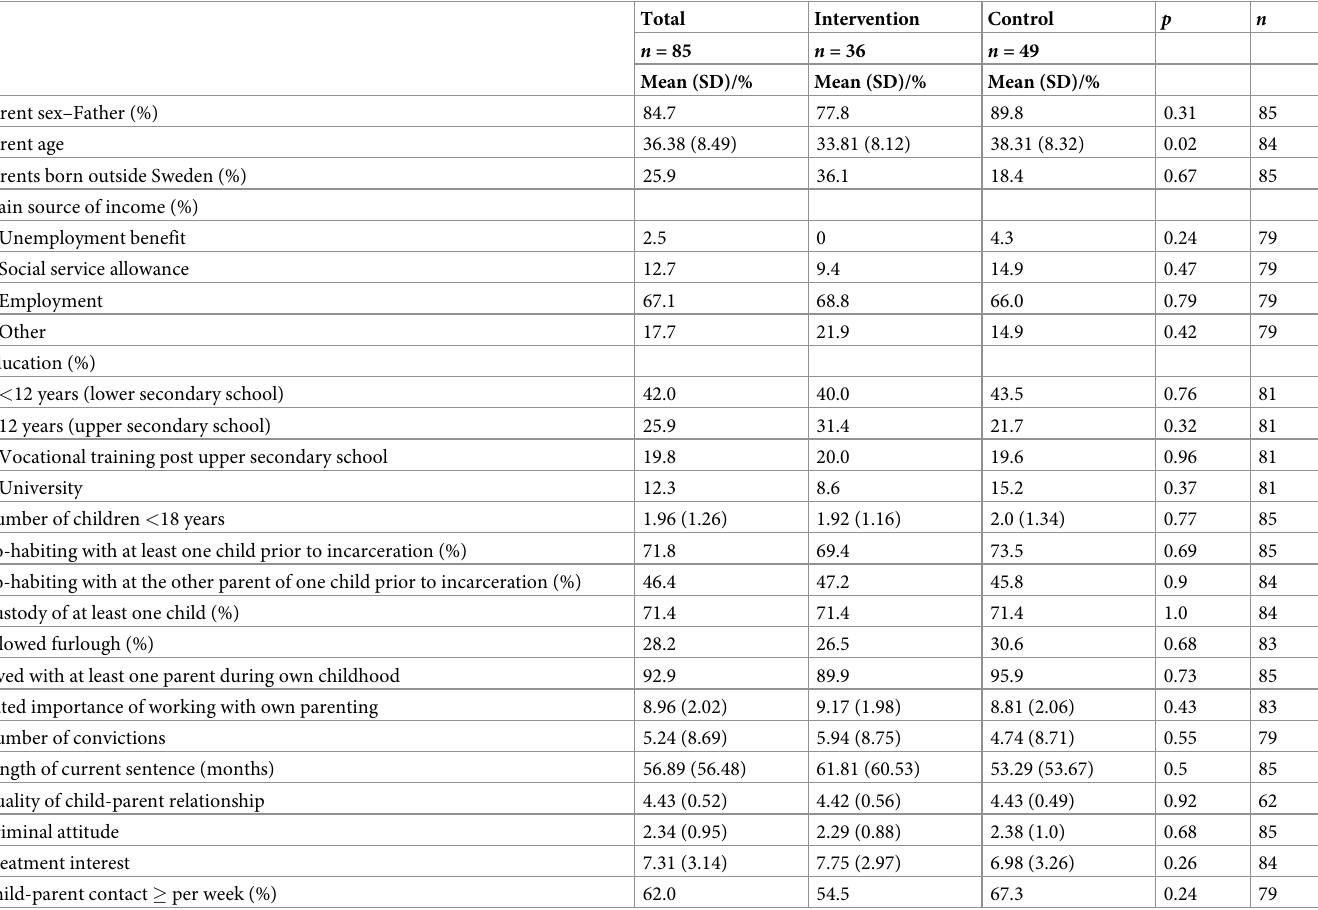
Table 1. Descriptive characteristics of parents at baseline in intervention and control